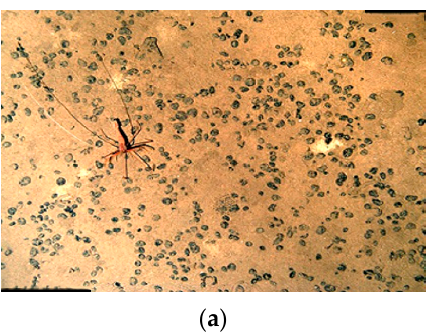
Figure 17. The fusion images for T3: ( a ) I-RANSAC; ( b ) IIR. For the same underwater image, the image fusion of T3( a ) can see the stitching trace, while the fusion trace of T3( b ) disappears.